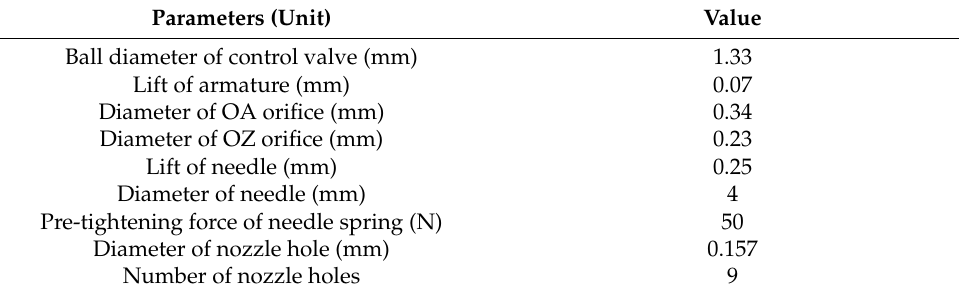
Table 1. Main structural parameters of the CR